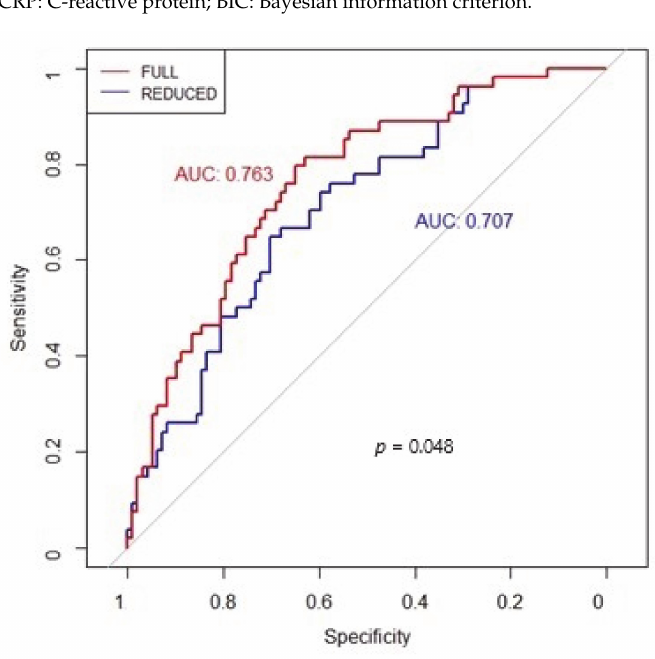
Figure 1. Receiver operating characteristic (ROC) curves were plotted to evaluate the performance of the selected Cox models showing the incremental prognostic value of electrocardiographic (ECG) signs of acute right ventricular (RV) strain (FULL model) over chest computed tomography (CT) scan without ECG signs of acute RV strain (REDUCED